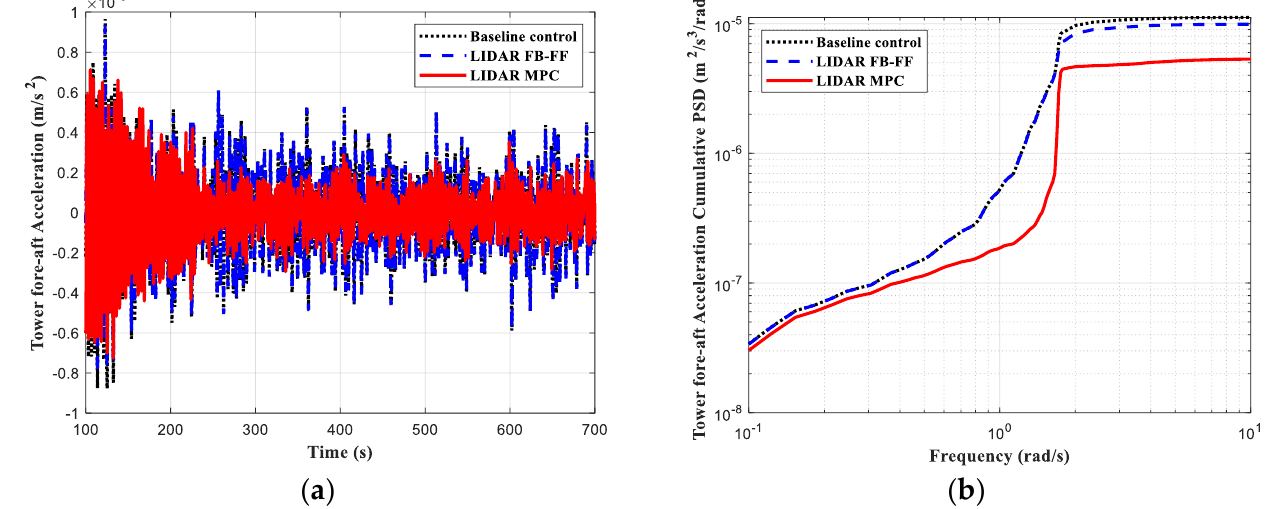
Figure 9. Tower fore-aft acceleration: ( a ) time profiles; ( b ) cumulative PSD (for wind speed with 10% turbulence intensity).